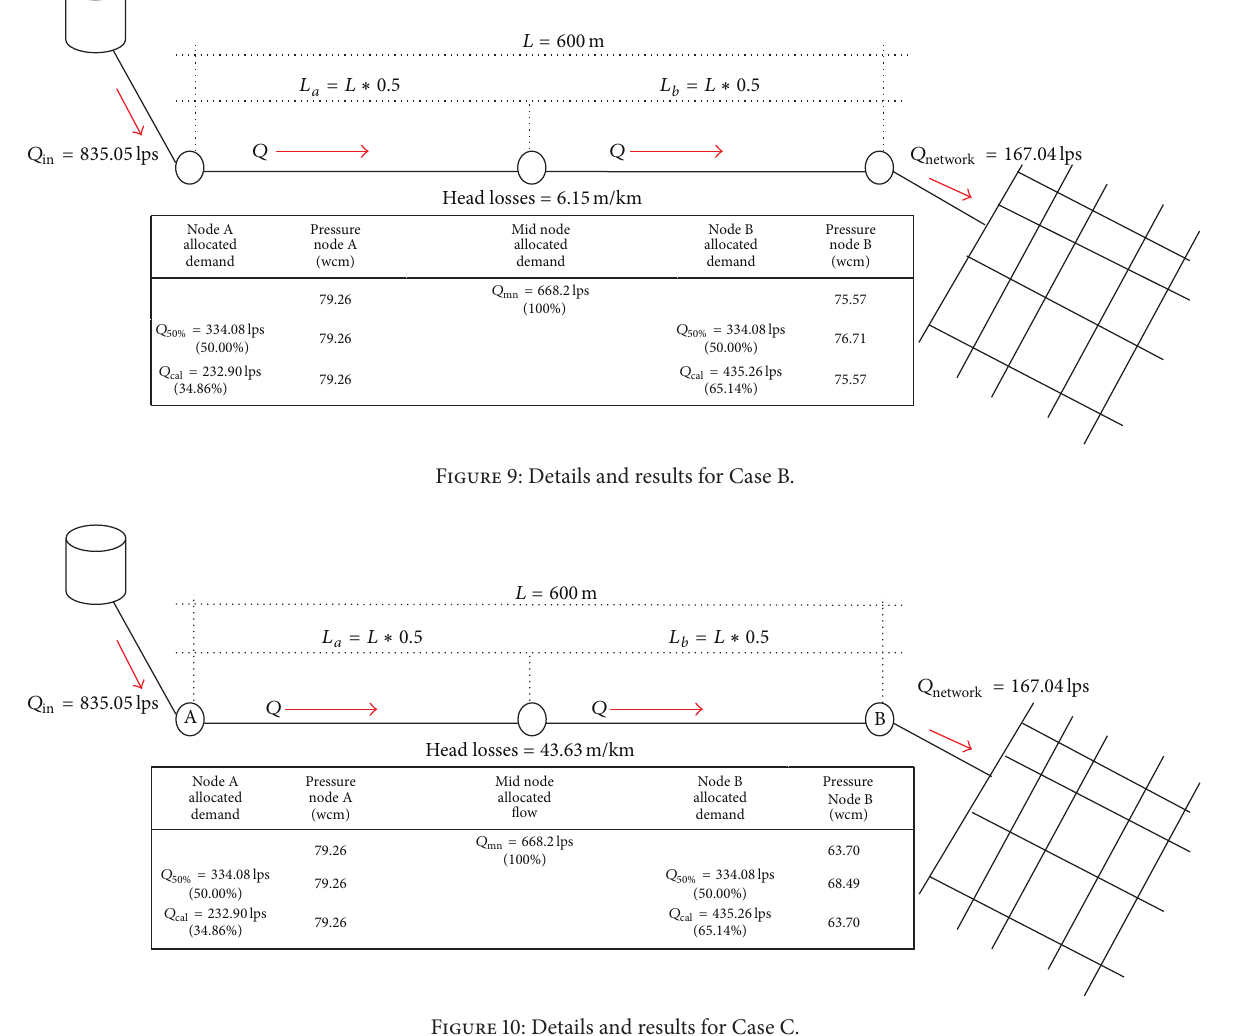
Figure 10: Details and results for Case C.